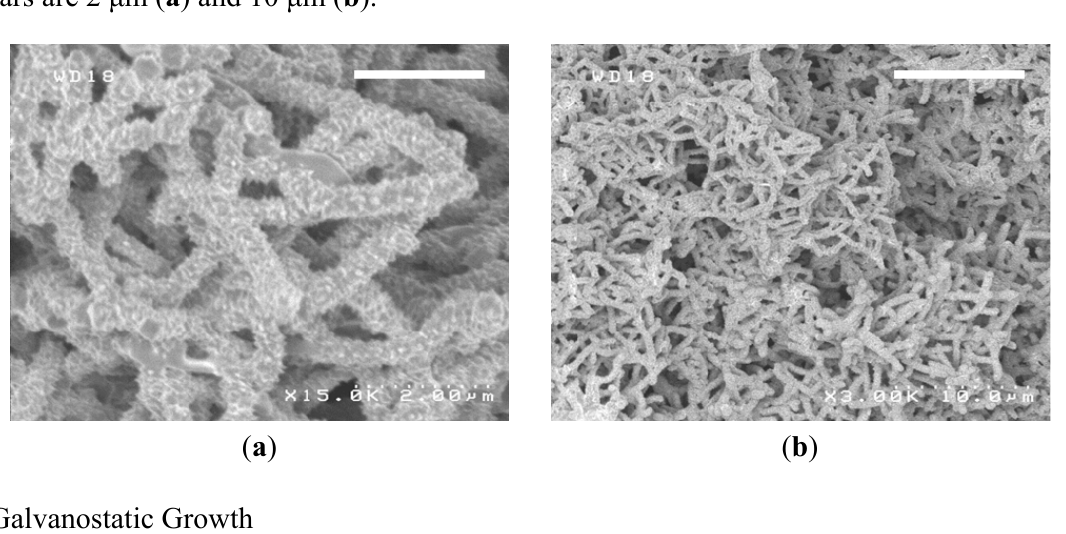
Figure 7. SEM images of the electrochemically synthesized polyaniline nanowires. Scale bars are 2 μ m ( a ) and 10 μ m ( b